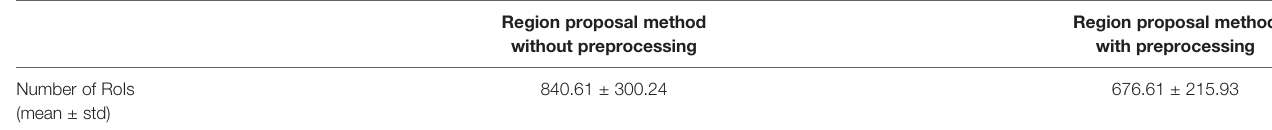
TABLE 1 | Statistics of RoIs achieved by the region proposal method with and without the preprocessing